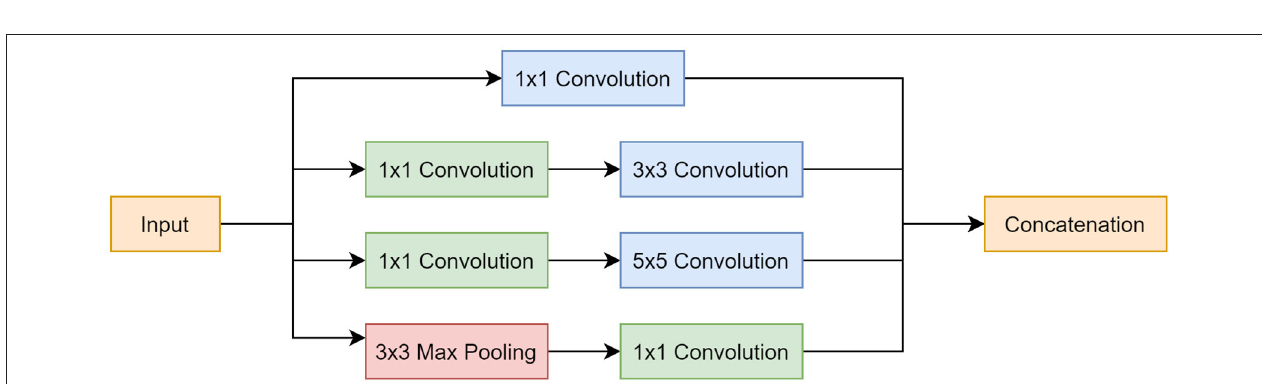
FIGURE 3 | Inception module block diagram. Top pathway follows a 1 × 1 convolution. Second pathway involves a 1 × 1 convolution, followed by a 3 × 3 convolution. Third pathway incorporates a 1 × 1 convolution, followed by a 5 × 5 convolution. Last pathway starts with a 3 × 3 max pooling layer and is followed by a 1 × 1 convolution. All pathways are concatenated at the end.